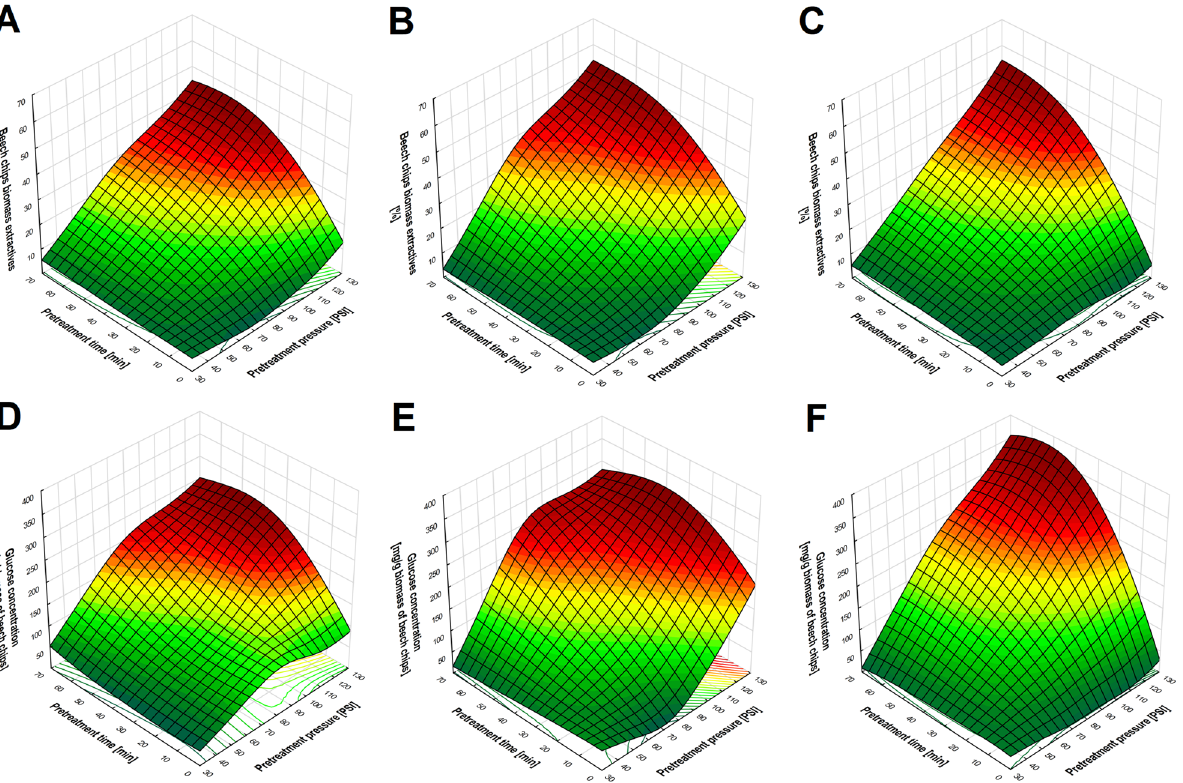
Figure 2. The effect of NaCS concentration (( A,D ) 10% w/v NaCS; ( B,E ) 20% w/v NaCS; ( C,F ) 40% w/v NaCS), pretreatment time and pressure on biomass extractives and on glucose concentration obtained by 72 h